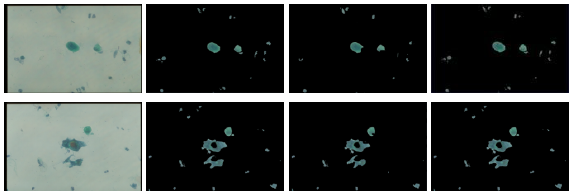
Figure 1. Examples of threshold segmentation results for blue dye images, from left: raw images, ground-truth data, results obtained with the faulty threshold, results obtained with a correct threshold.